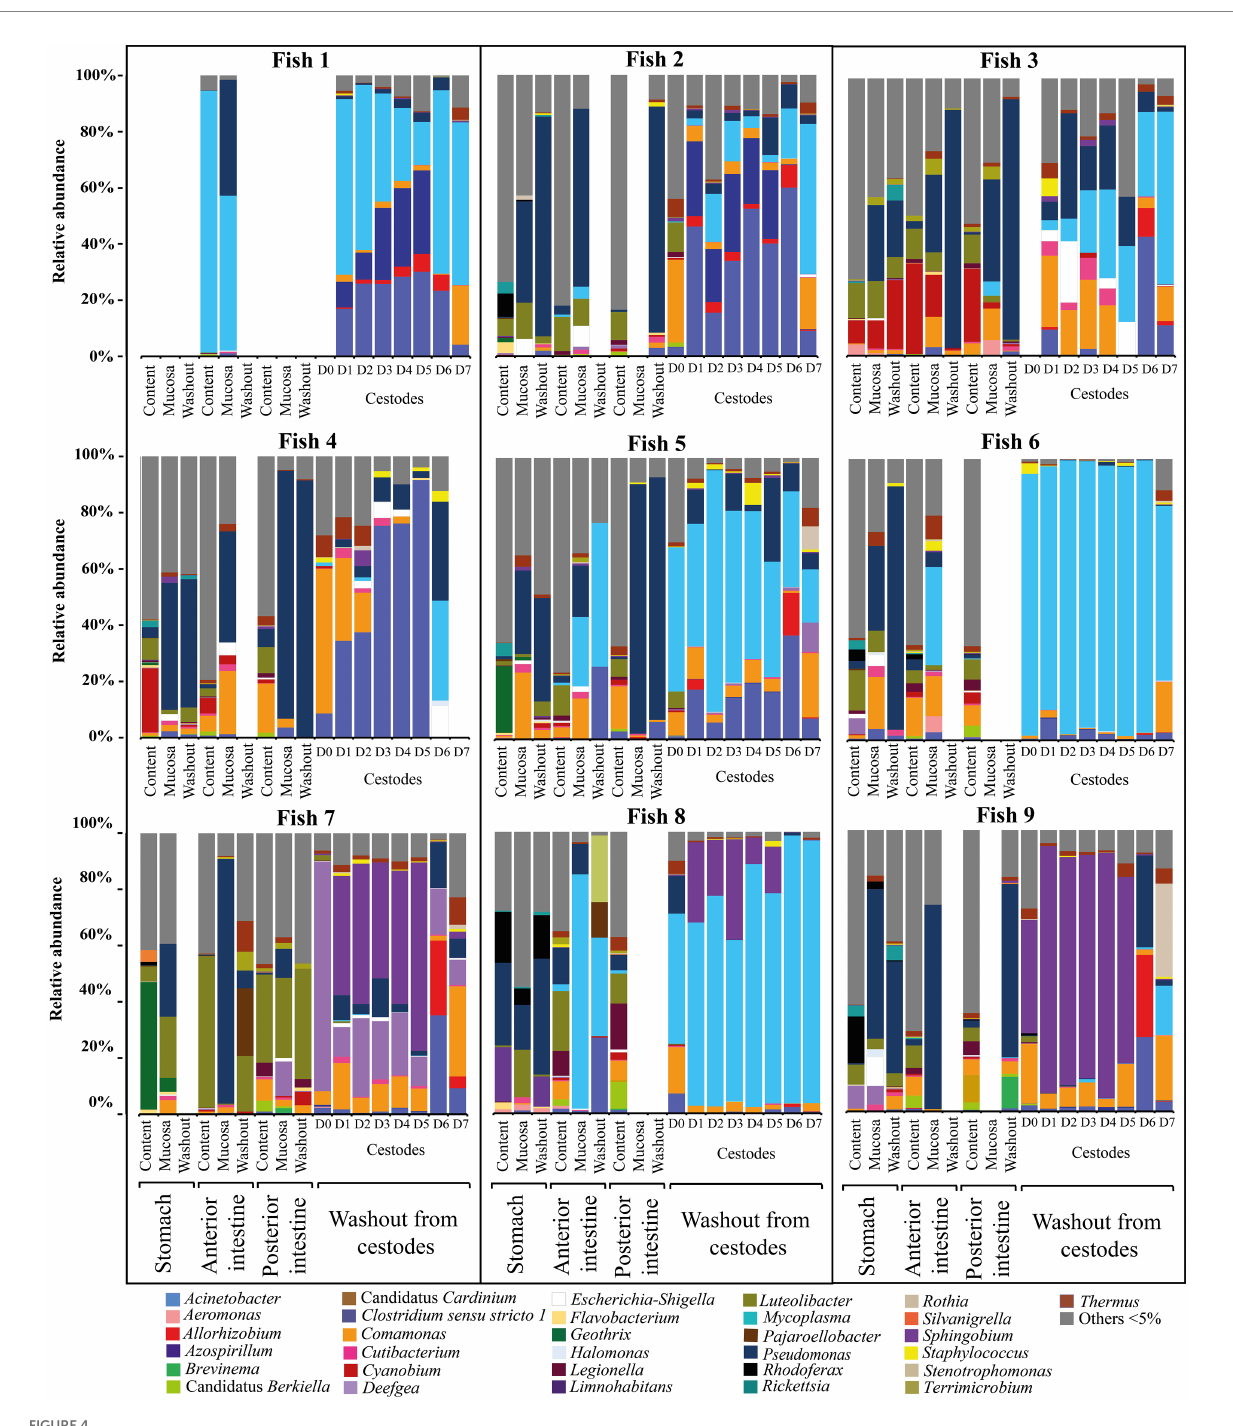
FIGURE 4 Individual microbial community of infected “normal” C. l. pidschian and microbiota associated with cestodes parasitizing the intestine of